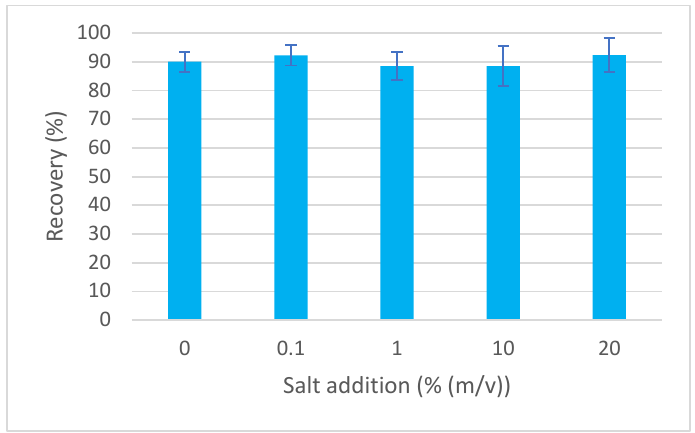
Figure 4. Dependence of recovery of EGDN on ionic strength.